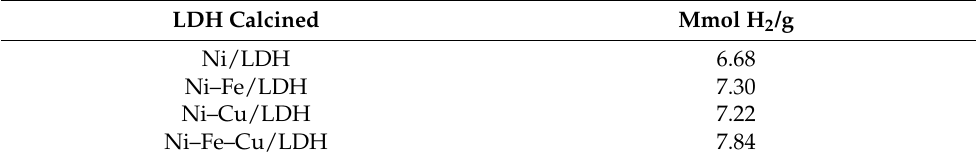
Table 4. Total consumption of H 2